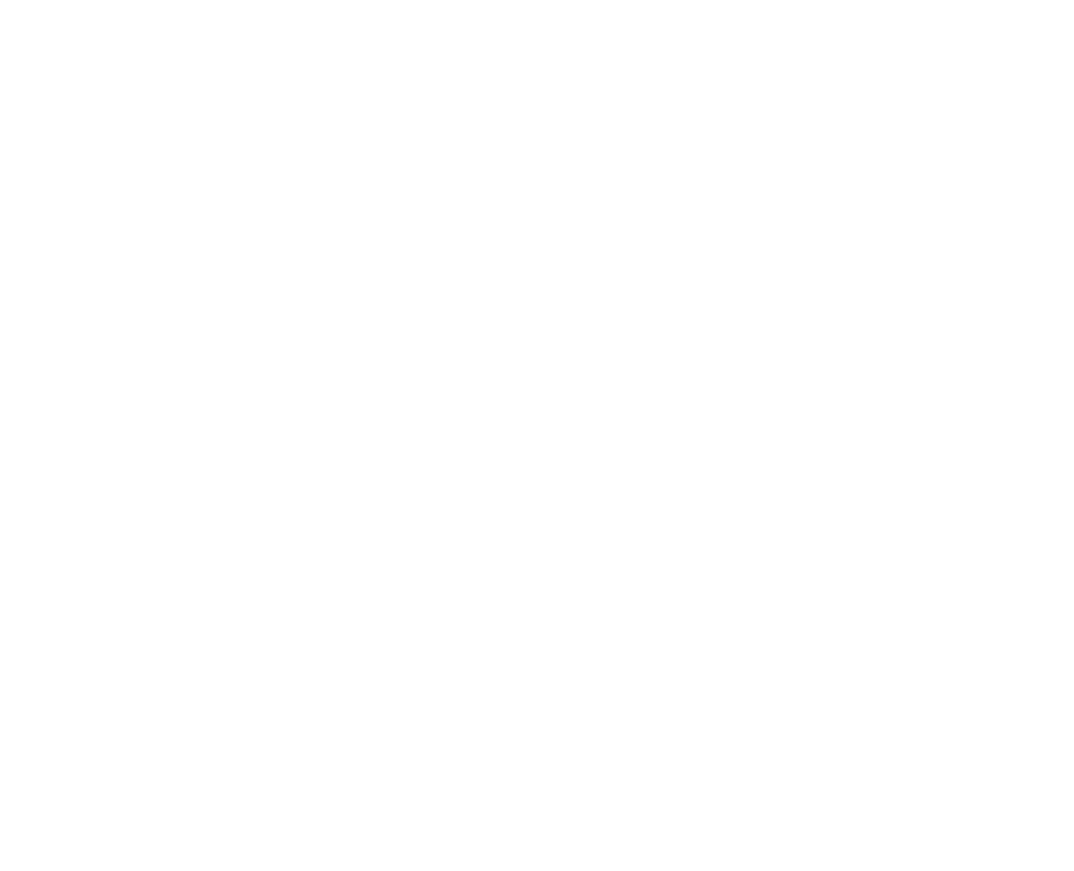
rifampicin; E, erythromycin; ENO, enrofloxacin;VA, vancomycin; Q/D, quinupristin/dalfopristin; LIN, linezolid; NF, nitrofurantoin;TGC, tigecycline; c , number of cats that contributed for the total number ( n ) of isolates. *Not applicable for E. faecalis isolates due to their intrinsic